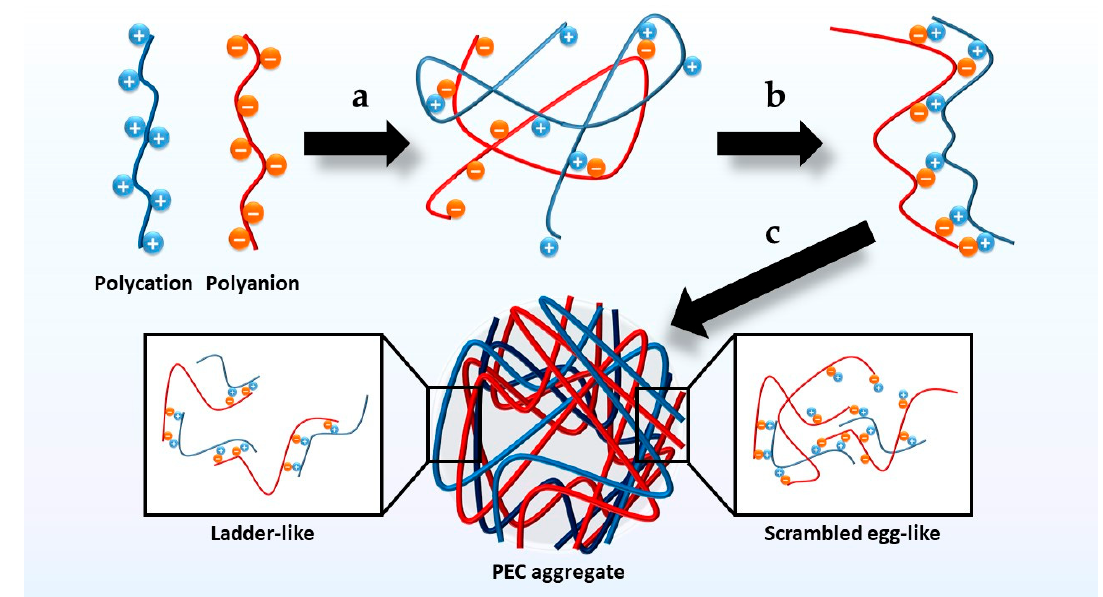
Figure 7. Diagram of the phases in the formation of polyelectrolyte complexes (PECs). ( a ) Establishment of secondary binding forces. ( b ) Formation of new bonds and correction of the distortions of the polymer chains. ( c ) Aggregation of the complexes formed through hydrophobic interactions.